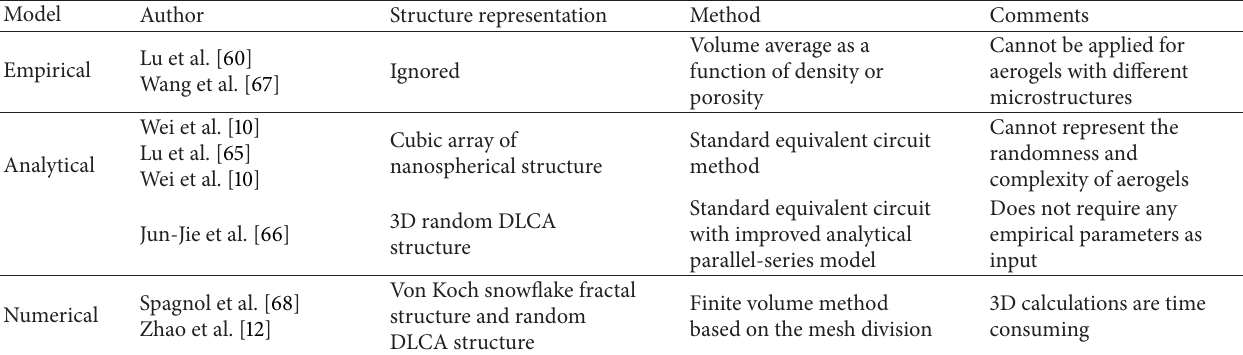
Table 2: Approaches to predict the thermal conductivity of silica aerogels (adapted from Jun-Jie et al.